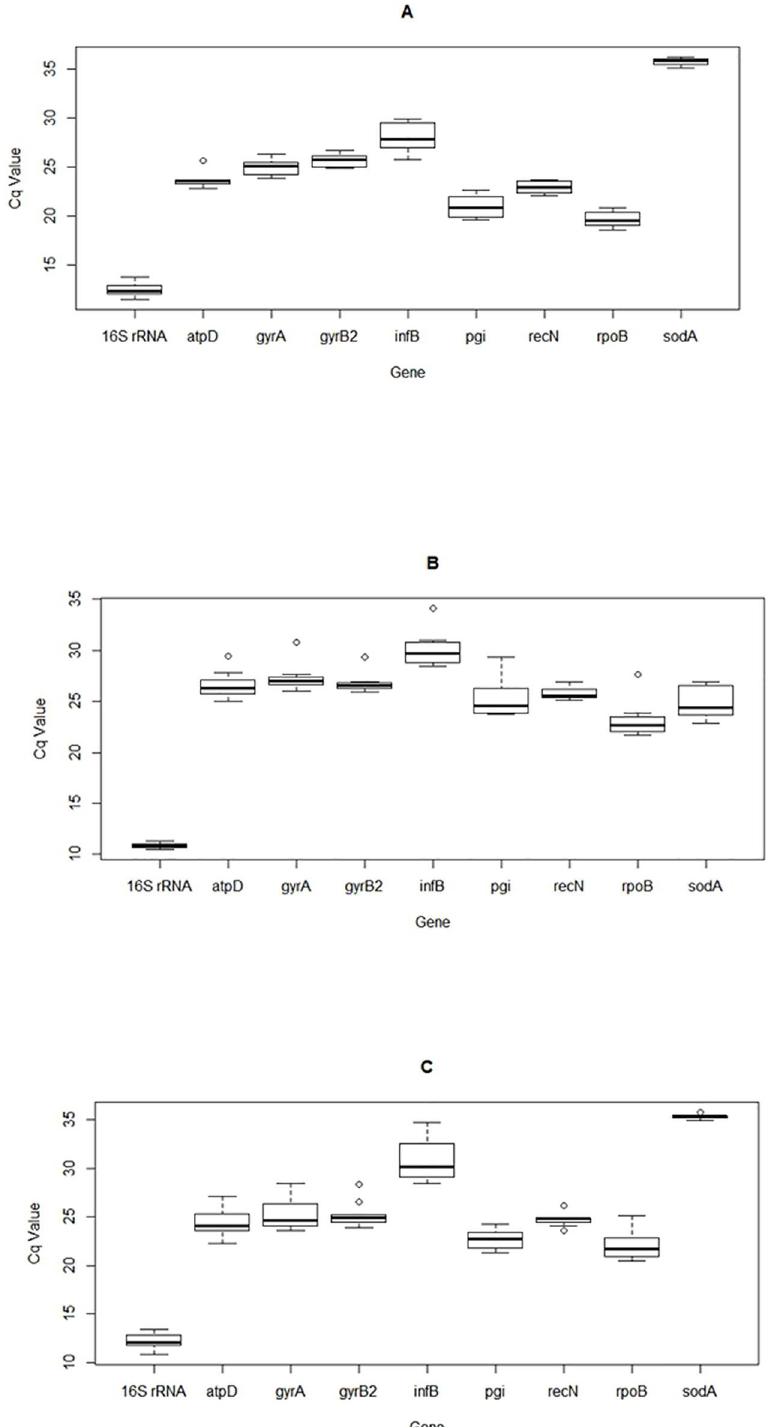
Fig 1. Range of Cq values of the nine candidate referencegenes across all samples of A . paragallinarum serovarsA, B, and C. Boxes and whiskers represent interquartile ranges and confidence intervals. Bars inside boxes indicatemedian values. Hollowcircles show outliers(5th/95th percentile) respectively.